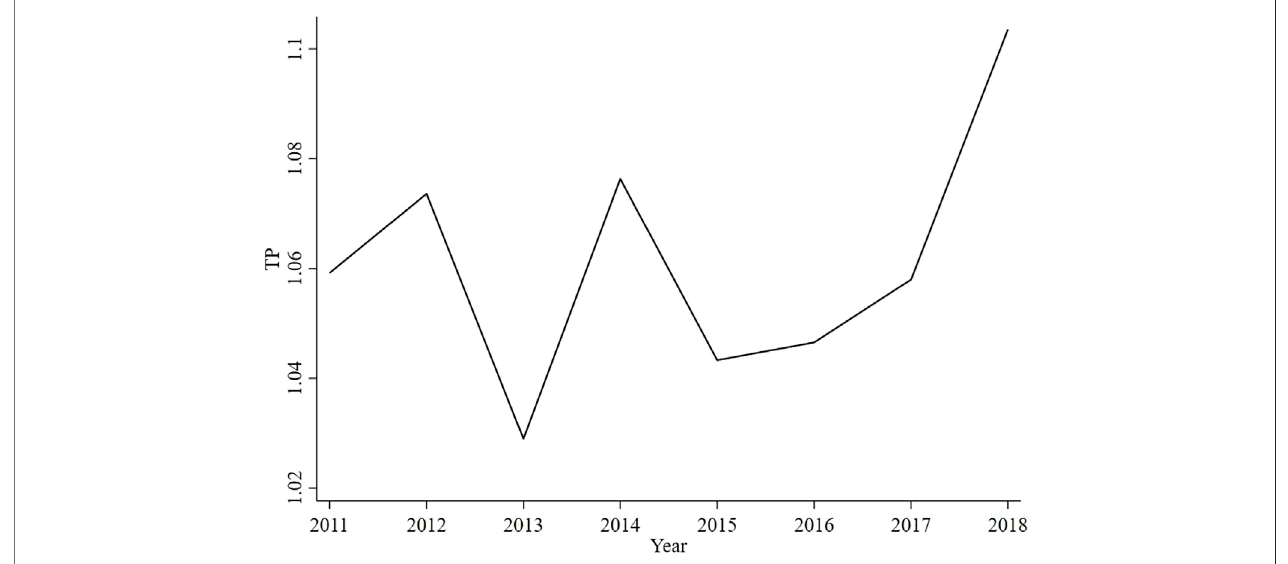
FIGURE1| Thetrend ofprovincial averagetechnologicalprogressfrom 2011to 2018.Source: Theoriginaldataiscollectedfrom China ’ s EnvironmentalStatistics Yearbook and calculated using MaxDEA.